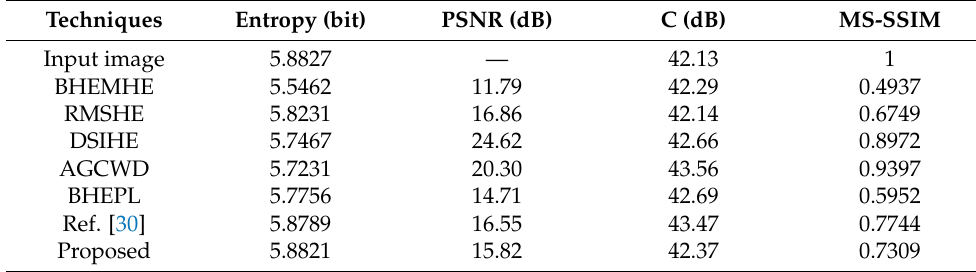
Table 3. Experimental data for the medium grayscale image